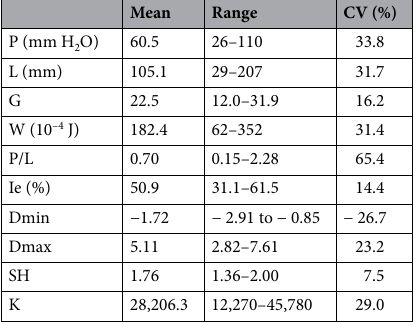
Table 1. Mean, range and coefficient of variation (CV) for the ten alveograph